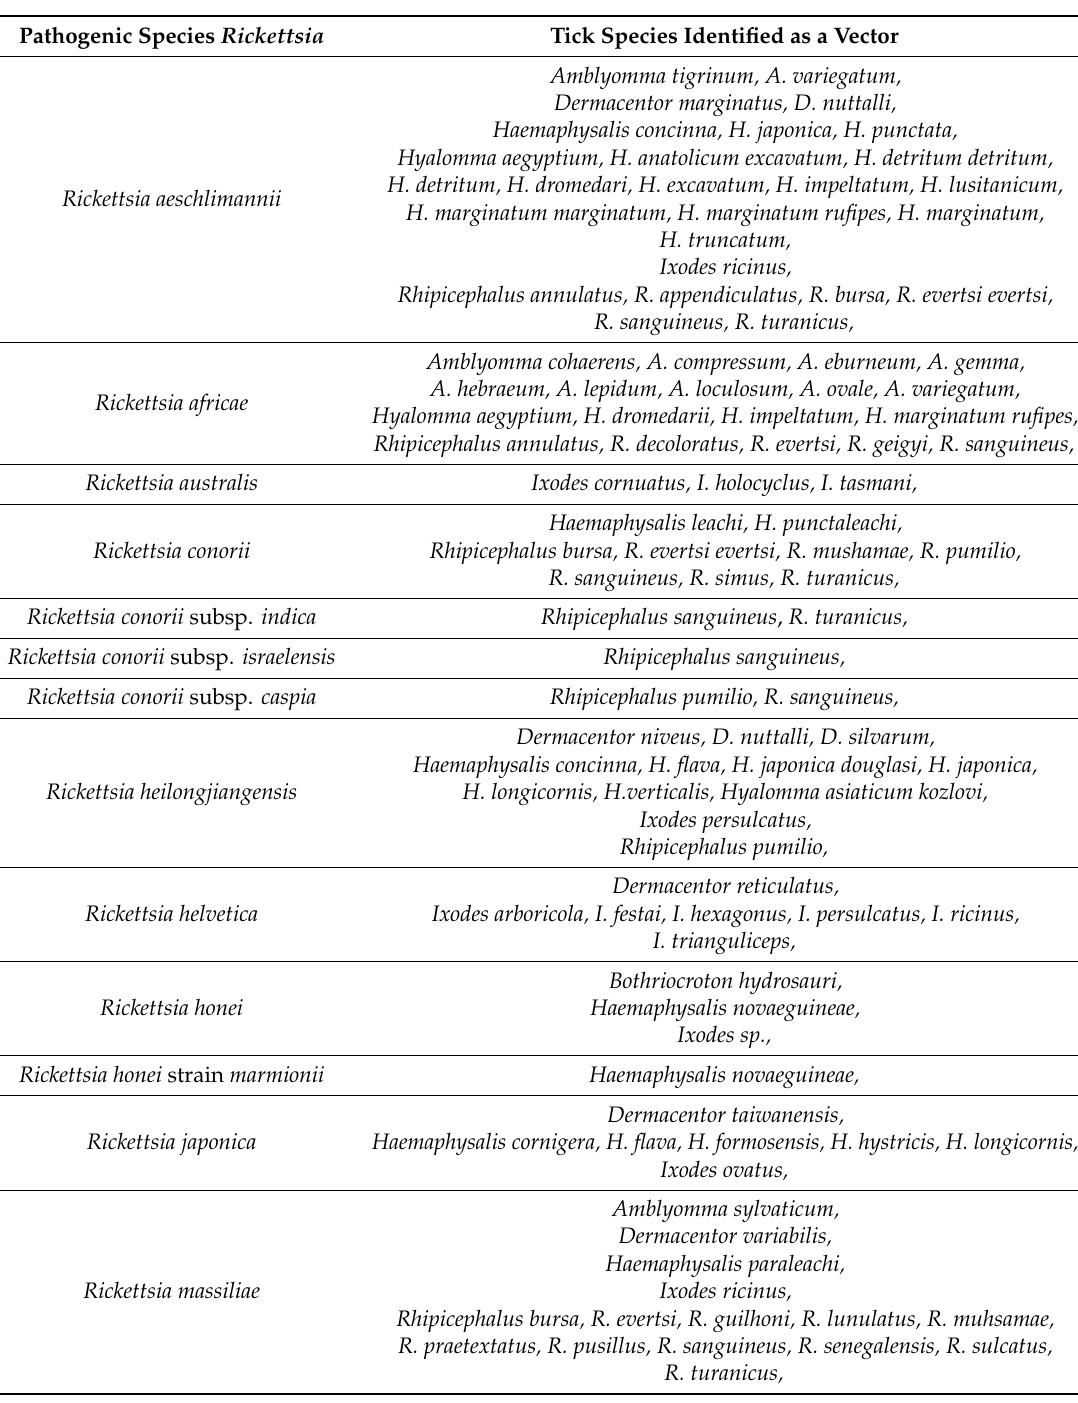
Table 1. List of currently known species of ticks transmitting pathogenic bacterial species of the genus Rickettsia